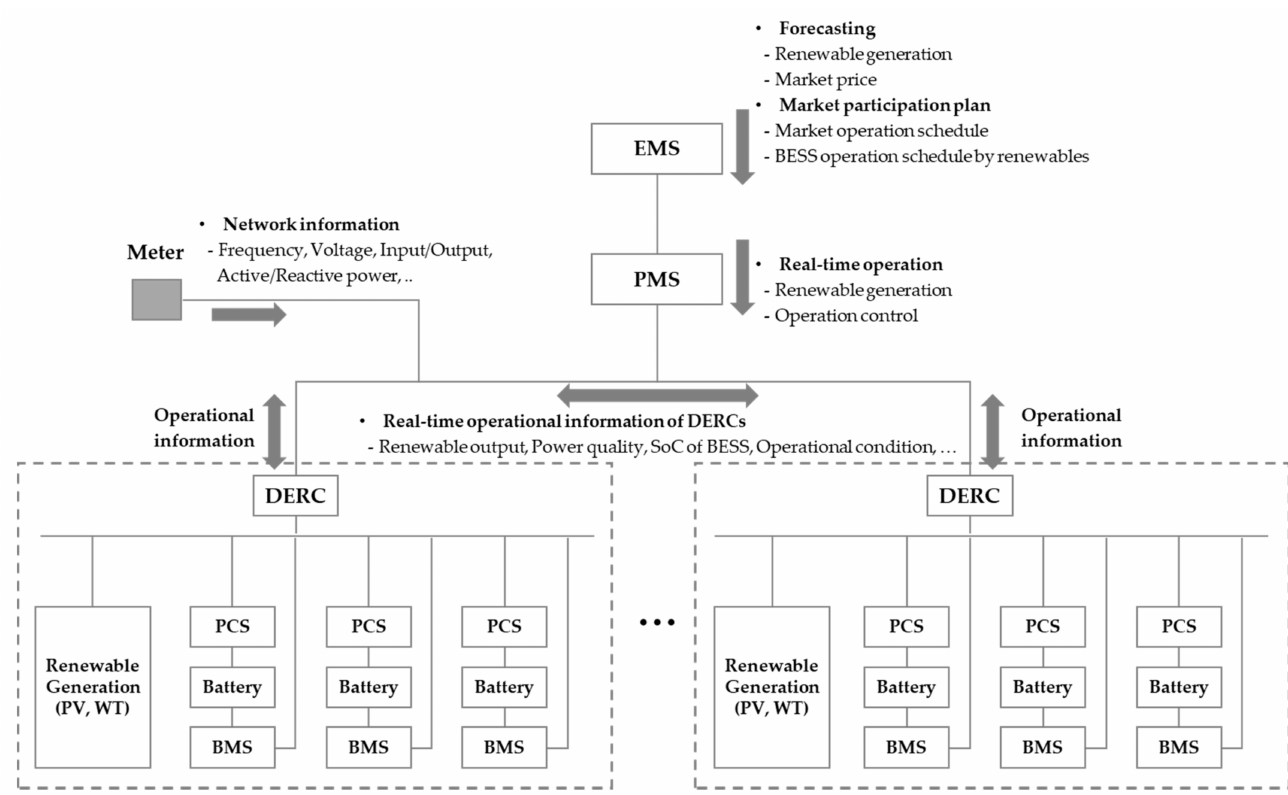
Figure 5. Proposed system configuration used to consider commercial FR market participation with a BESS and